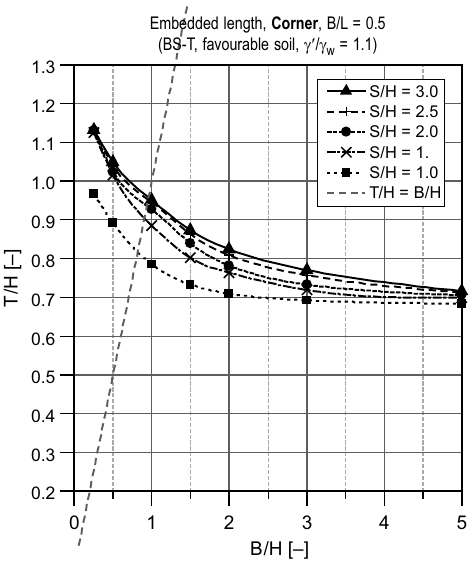
Fig. 5. Design chart for the corner area in homogenous, isotropic and favourable soil under three-dimensional conditions